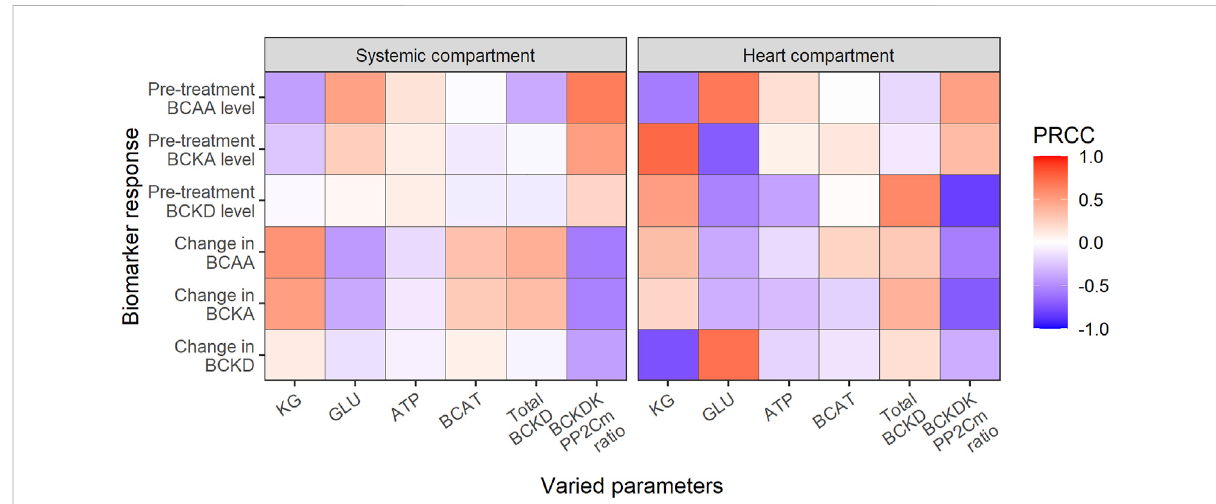
FIGURE 5 Globalsensitivityanalysis usingpartial rankcorrelationcoef fi cient(PRCC).Heatmapre fl ectsthedegreeofassociationbetweenparametersand biomarkers either at baseline (pre-treatment) or at treatment steady-state (change) after daily BT2 administration. Red and blue color denotes positive and negative association, respectively; KG — ketoglutarate, GLU —